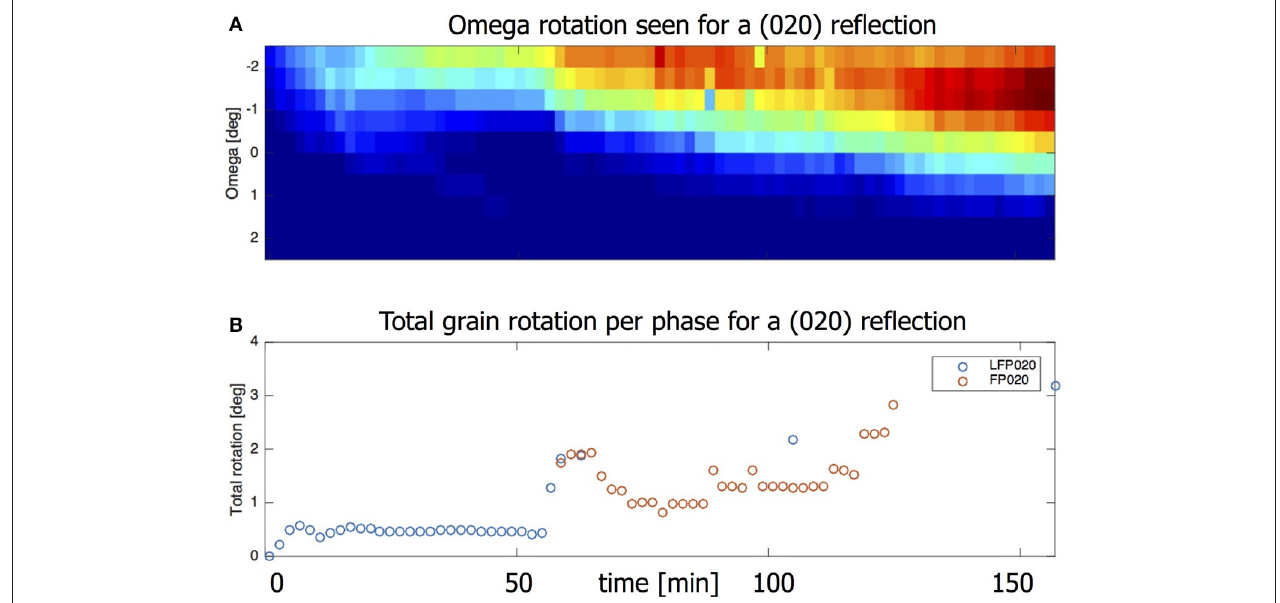
FIGURE 9 | (A) Heat map showing the omegas for which this is reflection is visible. Intensity first appears for ω = –2.5. At the end intensity is strongest for ω = –1 but is visible all the way to ω = 0.5. (B) The omega rotation taken together with the eta movement gives the total grain